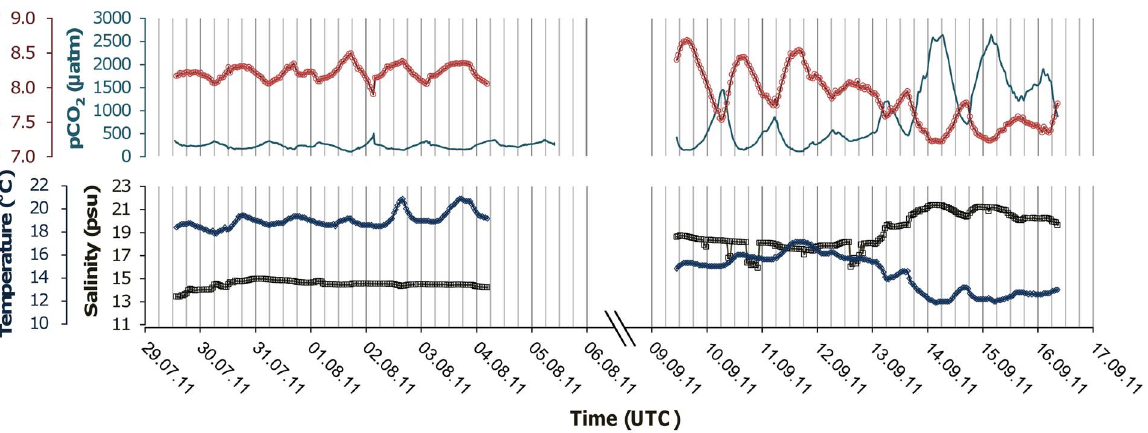
Figure 3. In situ measurements for August and September. pCO 2 (cyan), pH (red) Salinity (black) and temperature (dark blue) recorded in August (left) and September (right). The recording frequency was one minute for pCO 2 and 45 minutes for the 3 other parameters. Symbols in the plots mark the recording events; linkage between the measurements every 45 min was achieved by linear interpolation. Secondary vertical gridlines unit: 6 h.